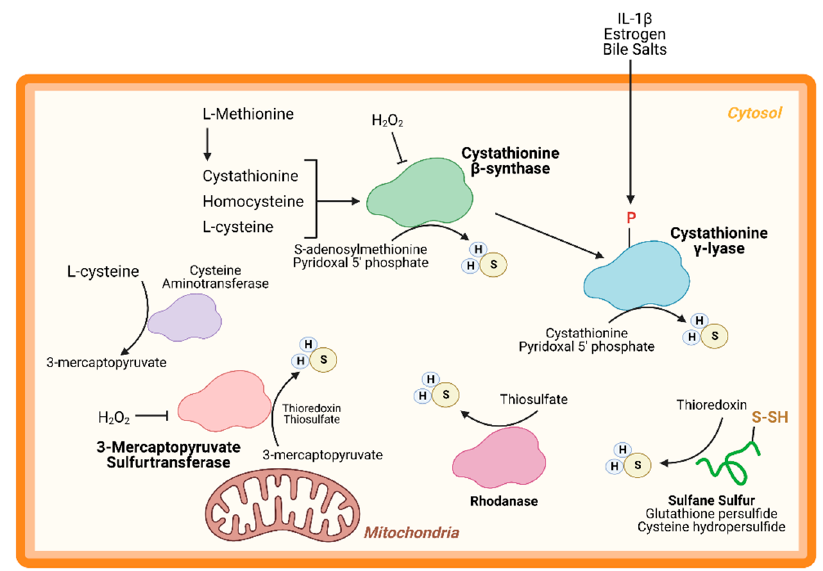
Figure 1. Hydrogen sulfide (H 2 S) Production. H 2 S is predominately produced by three enzymes—cystathionine- β -synthase, cystathionine- γ -lyase, and 3-mercaptopyruvate sulfurtransferase—and can be generated from other processes, such as sulfide quinone oxidoreductase and sulfane sulfur reservoirs (e.g., glutathione/cysteine (hydro)persulfides). H 2 S can modify free cysteines on enzymes, a reaction known as S-sulfhydration, to alter metabolic pathways, such as glycolysis, and induce up-regulation of metabolic genes via transcription factor activation.